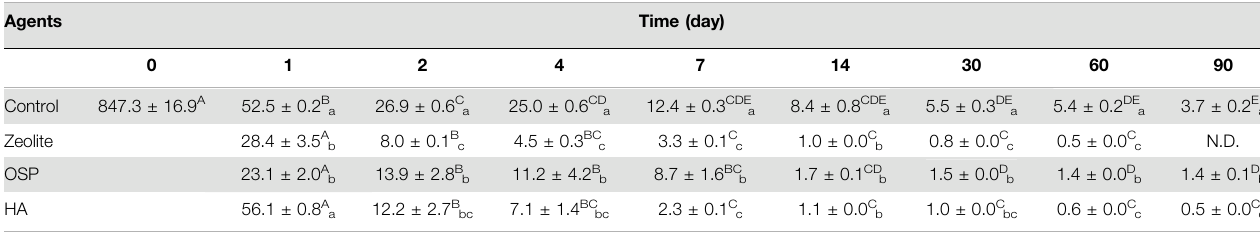
TABLE 7 | Concentrations of LMG ( μ g/L) in seawater after treating with three agents (200 mg/L) at observation point during 90 days.